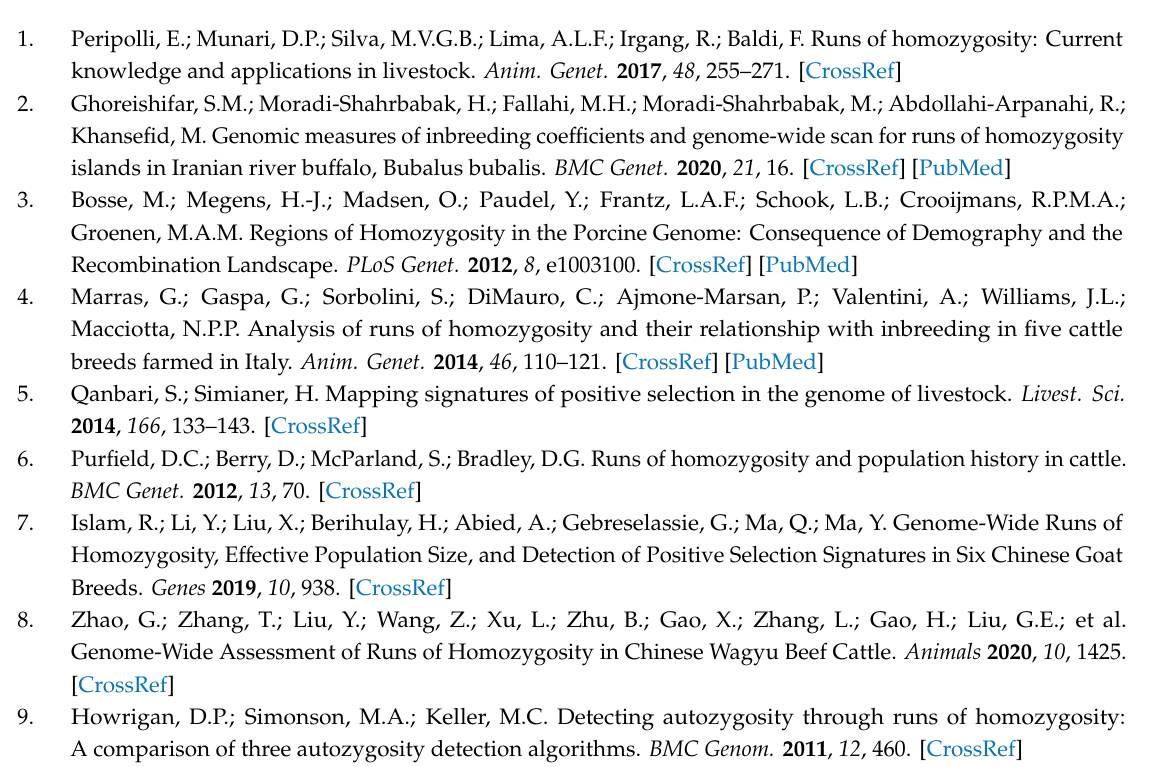
Figure S1. A correlation between the numbers of ROHs (n ROH) and the sum of all ROH segments; Figure S2. Linkage disequilibrium (LD) decay by distance across the five Chinese sheep breeds Hetian, Hu, Karakul, Wadi and Yabuyi. Table S1. Autozygosity islands were evident across the genome; Table S2. Go Terms with High ROH